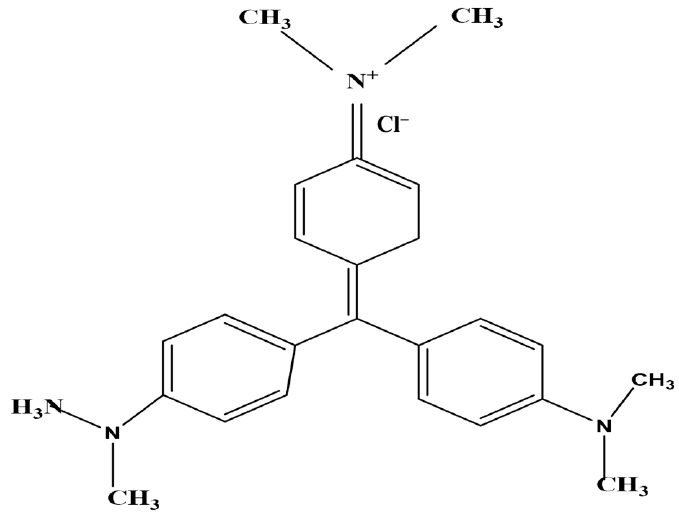
Figure 1. The chemical structure of the crystal violet dye (CVD).